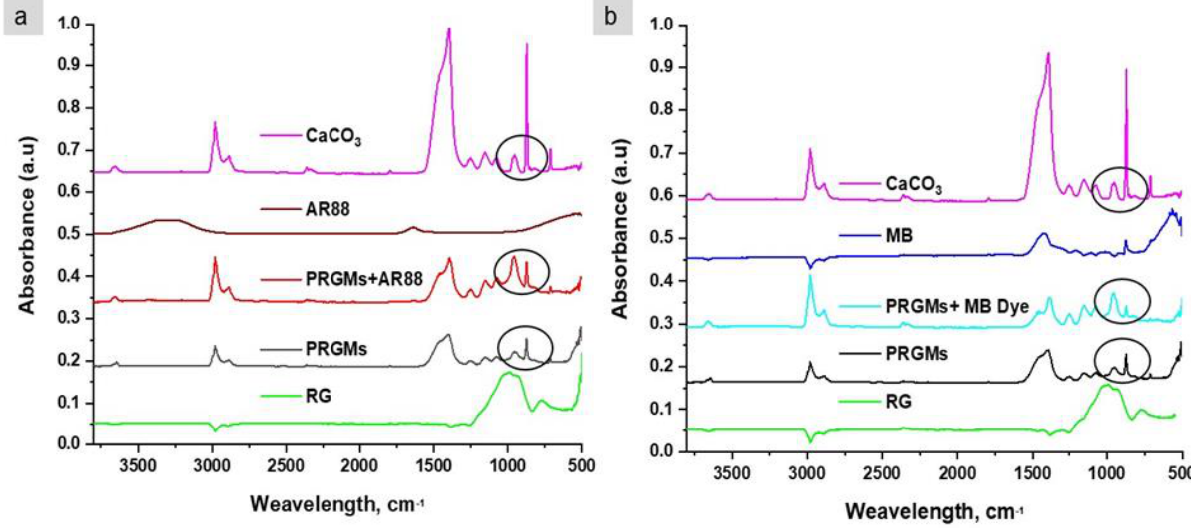
Figure 7. FTIR spectra for PRGMs before and after ( a ) AR88 and ( b ) MB dye adsorption. An intense adsorption at 1400–1500 cm –1 , along with an adsorption peak at 874 cm − 1 and 710 cm − 1 were observed for porogen (CaCO 3 ). These adsorption bands were assigned to stretching of C=O in CaCO 3 and CO 32 − [40]. These peaks were also present in PRGMs before and after AR88 and MB dye adsorption. However, after dye adsorption a decrease in relative absorption intensity at ~874 cm − 1 was observed for PRGMs+AR88 dye and PRGMs+MB dye (see Figure 7a,b) [40]. No noticeable peak shift or change in relative intensity was observed in the rest of the spectrum. The characteristic adsorption band for AR88 and MB dye were not detected in PRGMs+AR88 dye and PRGMs+MB dye. As a result, XPS studies were performed for further investigation, which investigated dye in- teraction on the surface of the PRGMs before and after dye adsorption. As shown in Figure 8, peaks corresponding to Si 2p, O 1s, C 1s and Ca 2p can be clearly identified in the survey